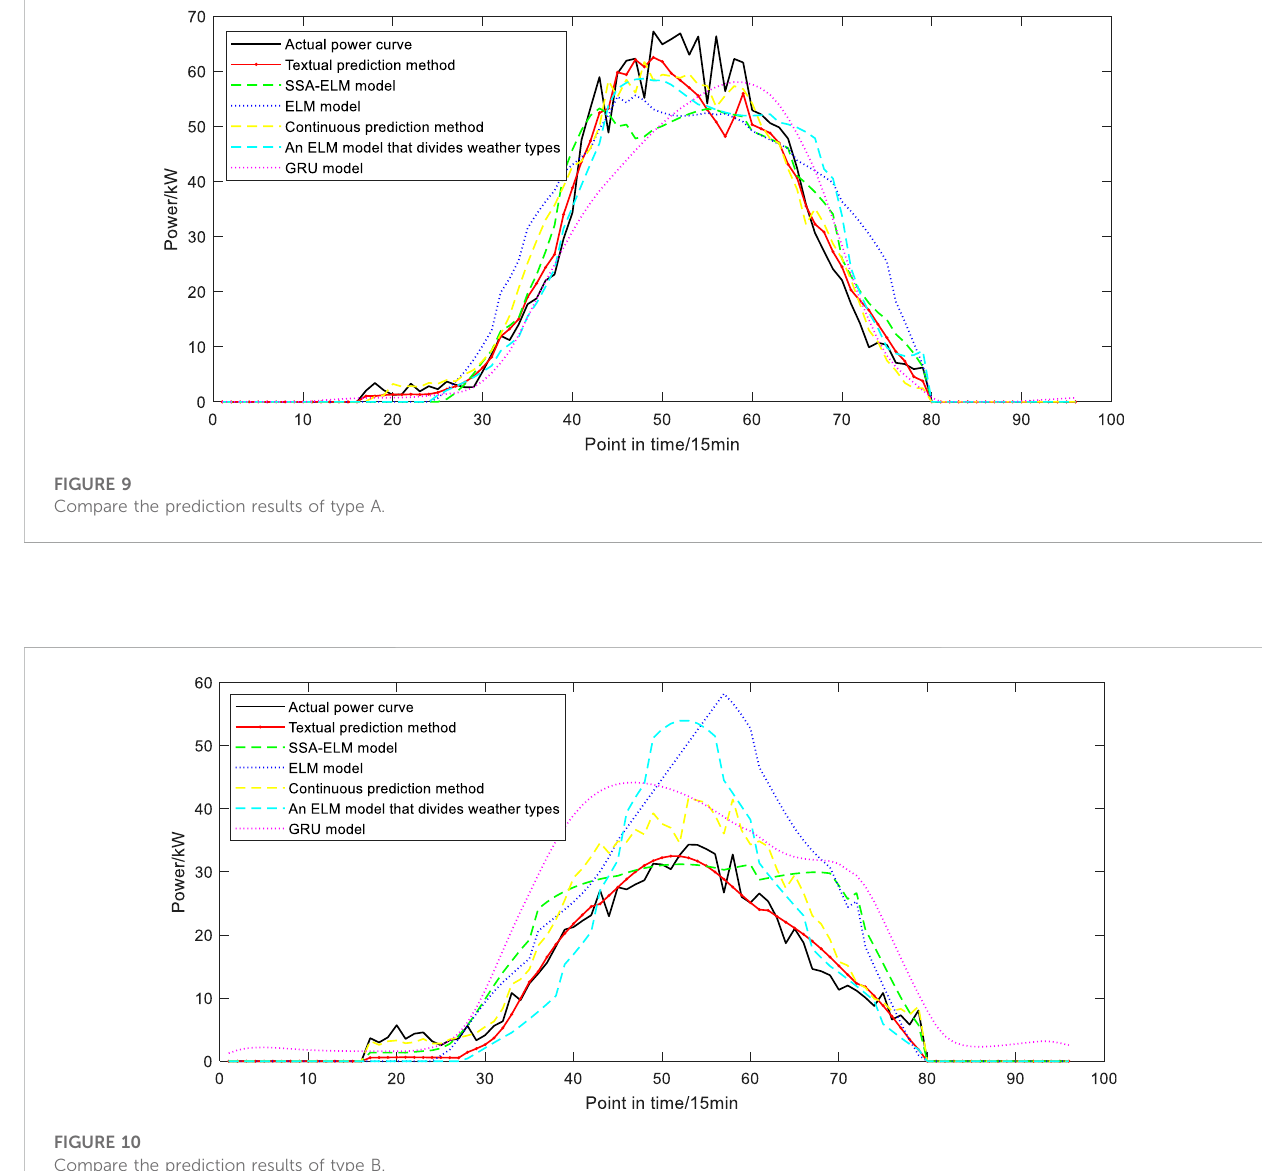
FIGURE 10 Compare the prediction results of type B.